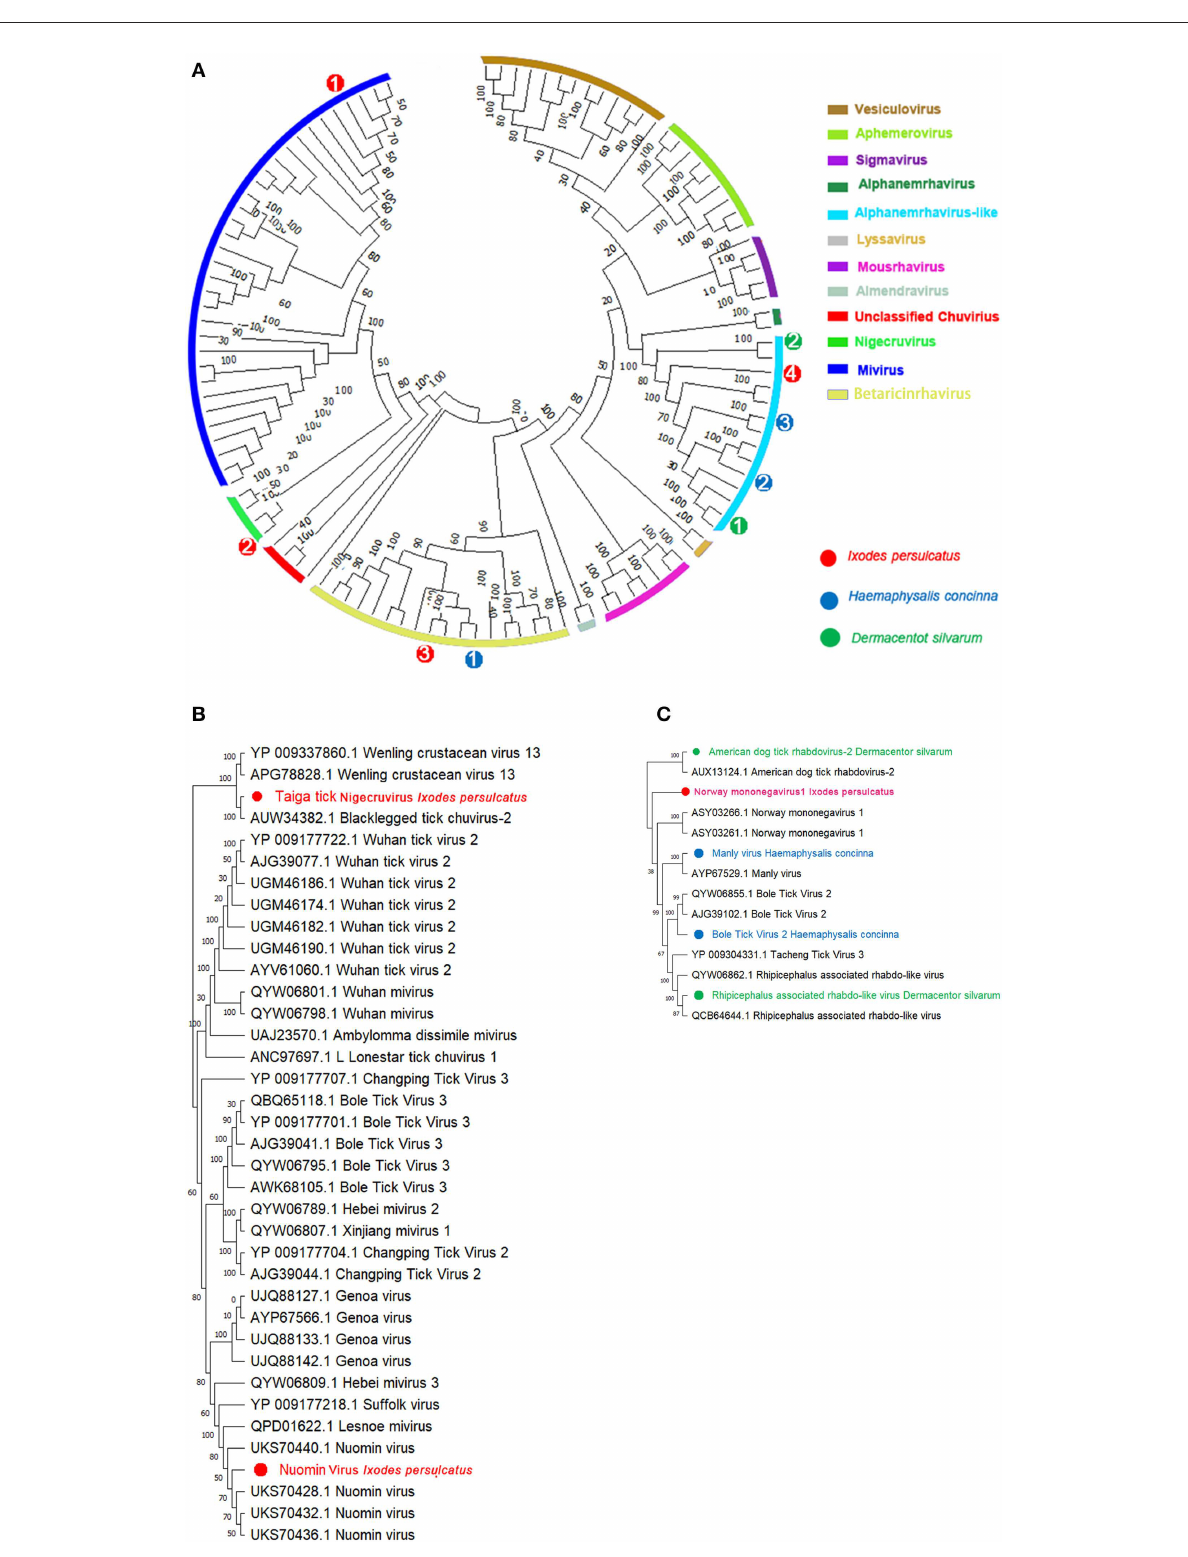
FIGURE2 Phylogenetic analysis of representative branches in the order Mononegavirales . (A) Alignment of all branches belonging to the order Mononegavirales . (B) Enhanced region showing the genera relationship of Mivirus and Nigecruvirus . (C) Enhanced region showing